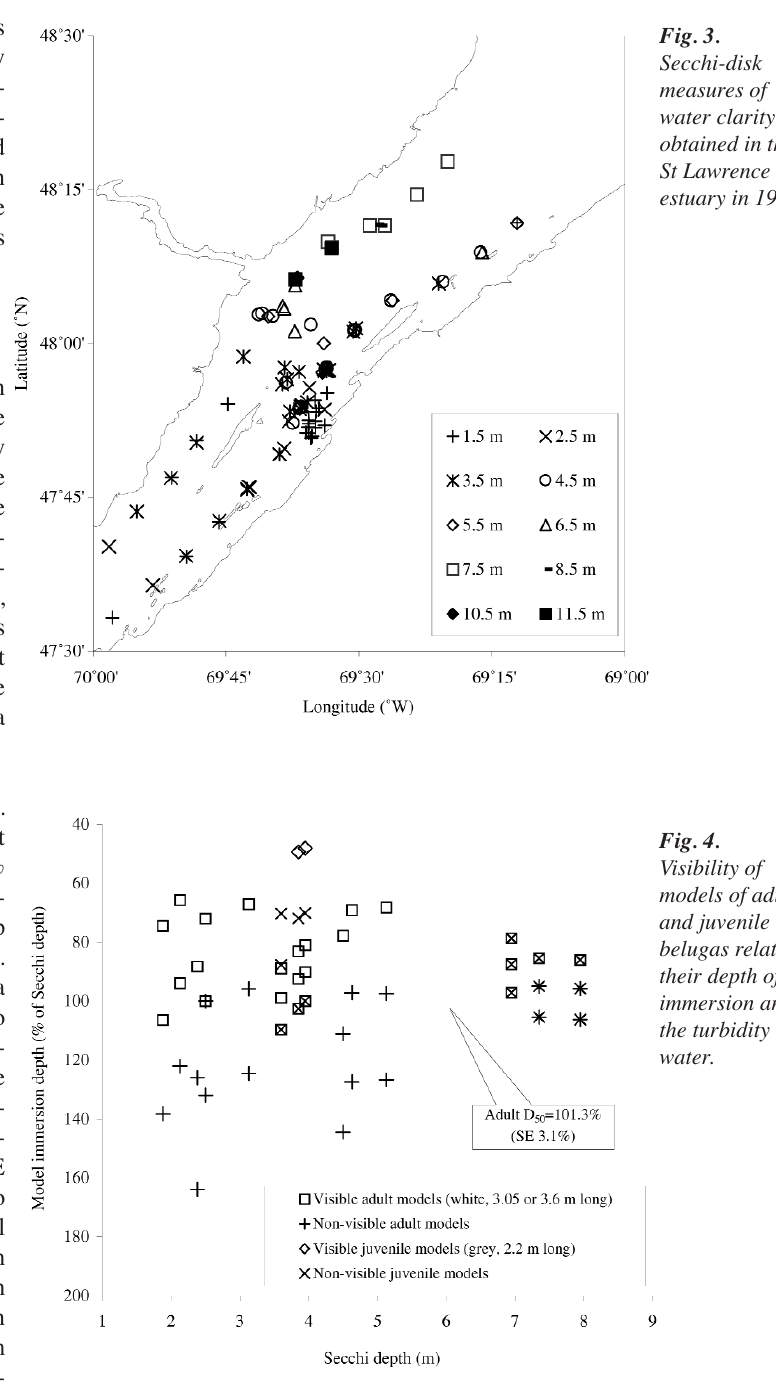
Fig. 3. Secchi-disk measures of water clarity obtained in the St Lawrence estuary in 1997.